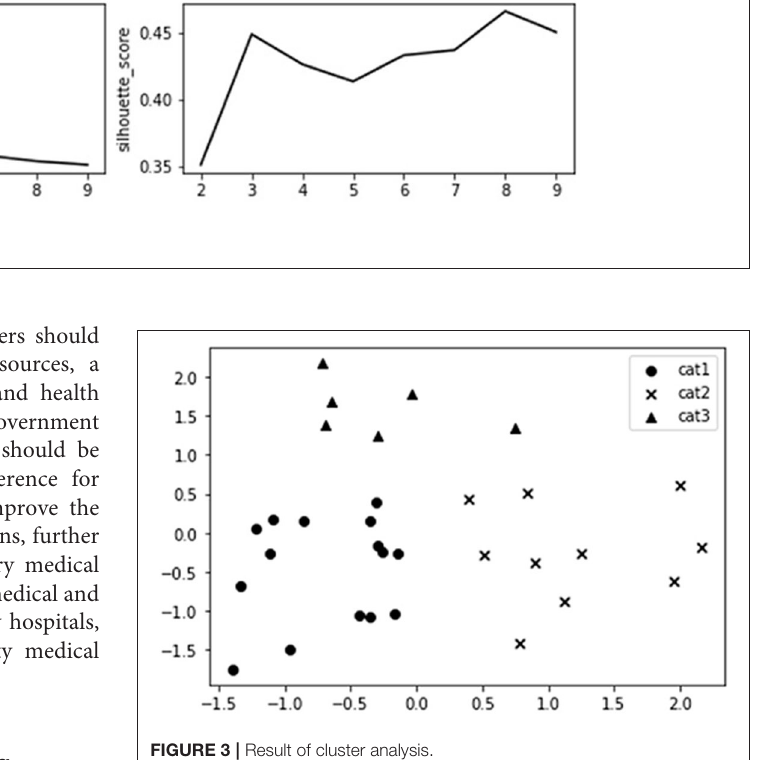
FIGURE 3 | Result of cluster